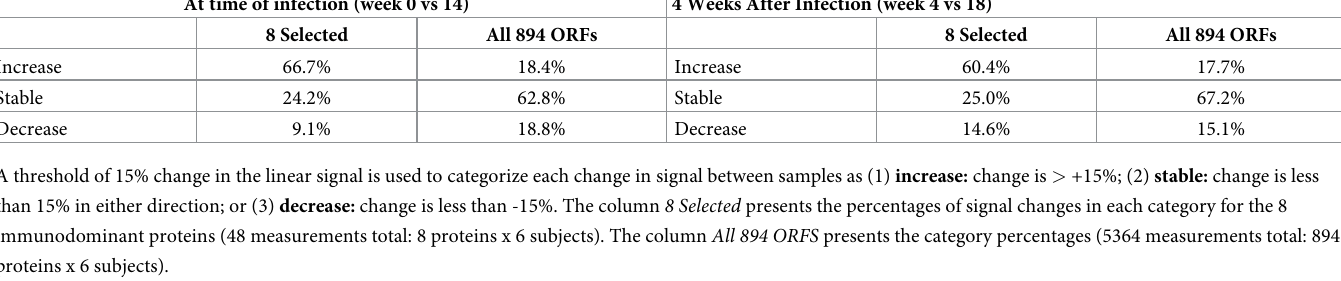
To determine the serum IgG IFA titers to C . trachomatis serovar D, samples were collected before infection as a control and at week 8 following the primary and secondary infections (S1 Table). All infected monkeys had C . trachomatis- specific antibody titers at week 8 ranging from 1:100 to 1:1,600. At week 8 after the secondary infection, the IFA titers of the infected monkeys ranged from 1:50 to 1:400. No significant differences in antibody titers were observed between monkeys infected with 10 5 or 10 7 C . trachomatis IFU. Therefore, both groups were used for analyses. Control mock-infected monkeys were all negative (titer < 1:50; data not shown).